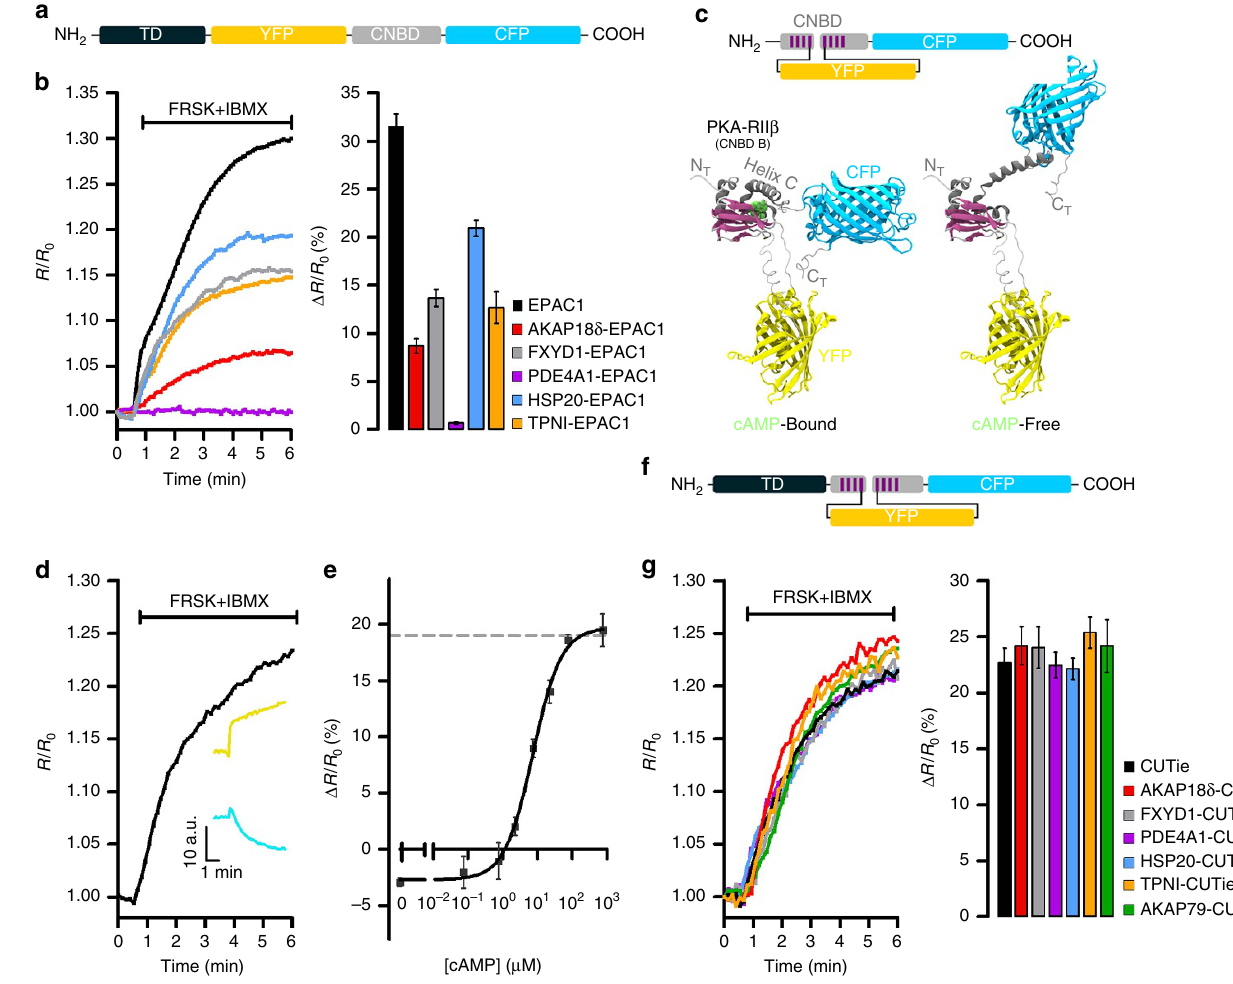
Figure 1 | Generation of a universal FRET-tag for cAMP detection at specific macromolecular complexes. ( a ) Schematic representation of the targeted Epac1-camps chimeras. CNBD, cyclic nucleotide binding domain; TD, targeting domain. ( b ) Representative kinetics of cAMP change (left panel) and summary of the experiments performed (right panel) in CHO cells expressing untargeted Epac1-camps (EPAC1) or its targeted versions upon application of the adenylyl cyclase activator forskolin (FRSK, 25 m M) and the phosphodiesterase inhibitor 3-isobutyl-1-methylxanthine (IBMX, 100 m M), a treatment that generates an intracellular amount of cAMP that saturates Epac1-cAMPs (ref. 27). AKAP18 d , A-kinase anchoring protein 18 d (ref. 17); FXYD1, phospholemman; HSP20, heat shock protein 20; TPNI, troponin I; PDE4A1, phosphodiesterase 4A1. Bars show FRET change at saturation. N Z 5 from at least five independent experiments, all samples are significantly different from each other by one-way ANOVA and Bonferroni post hoc test, P r 0.05, except FXYD1-EPAC1 versus TPNI-EPAC1, which is not significant. ( c ) Top: schematic representation of CUTie. Bottom: ribbon representation of the predicted molecular structures of CUTie in its cAMP-bound or cAMP-free forms. cAMP is shown in green. ( d ) Representative kinetics of FRETchange and corresponding CFP and YFP emission intensity curves (inset) recorded in a CHO cell expressing CUTie and treated with a saturating stimulus. ( e ) Concentration–response calibration curve generated using CHO cells expressing CUTie and microinfusion of known concentrations of cAMP via a patch pipette. EC 50 ¼ 7.4 m M, sensitivity range between 0.5 m M and 50 m M. Hill coefficient is 1.07. Broken line indicates maximal FRET change as predicted by MD simulations. ( f ) Schematic representation of CUTie chimeras. For each concentration point N Z 5 from at least five independent experiments. ( g ) Representative kinetics of FRETchange (left panel) and mean maximal FRETchange (right panel) recorded at saturation. N Z 10 from three independent experiments. One-way ANOVA analysis with Bonferroni’s post hoc correction shows no significant difference between all samples. AKAP79, A-kinase anchoring protein 79. All values are means ±